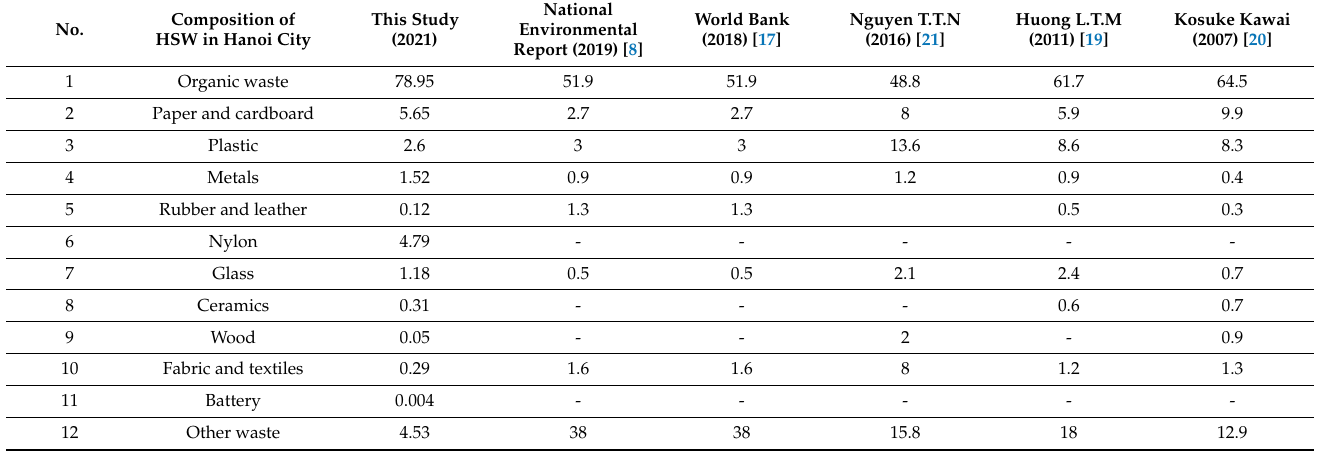
Table 4. Comparison of HSW composition among studies and reports.